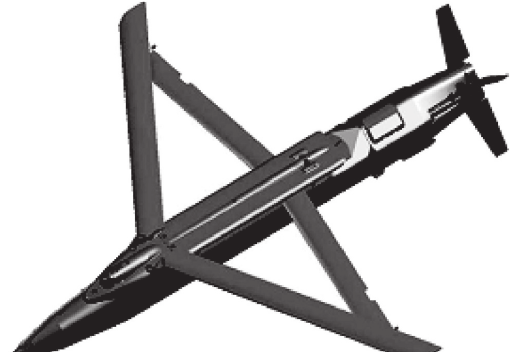
Figure 1: Sketch of small diameter bomb with diamond back